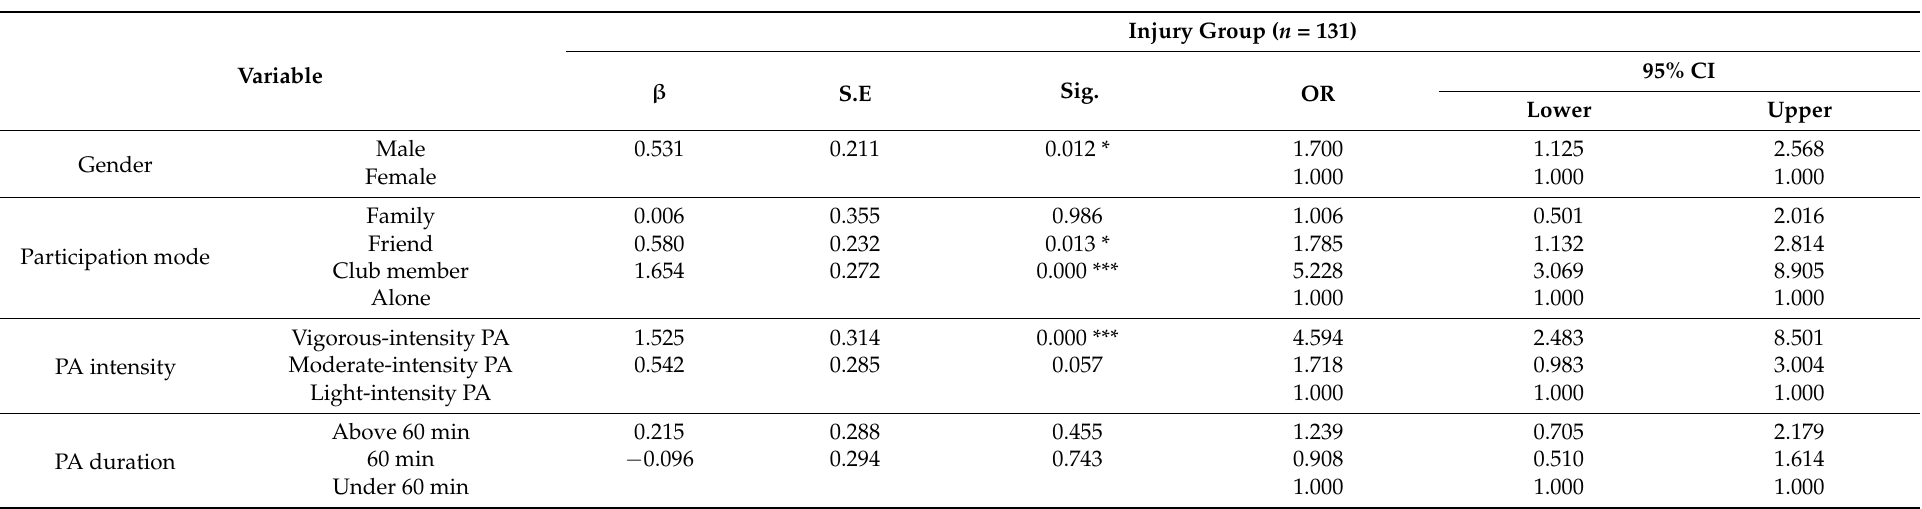
Table 3. Multinomial logistic regression